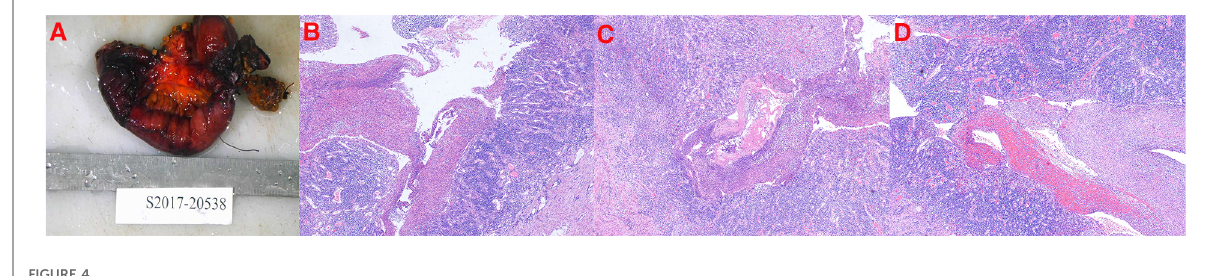
FIGURE 4 Postoperative pathological fi ndings of the third admission procedure. ( A ): Small bowel removed for partial jejunectomy. ( B – D ): The pathology of the small intestine resected after the operation shows a chronic in fl ammation of the jejunal mucosa with ulceration, necrosis, and exfoliation of a part of the mucosa, pus on the surface of the intestinal mucosa, and in fi ltration of many lymphocytes, plasma cells, and a small number of neutrophils and eosinophils in the full thickness of the intestinal wall. Full-thickness blood vessels in the intestinal wall are proliferated, dilated, and congested with hemorrhage, and fi brinous necrosis is seen in some blood